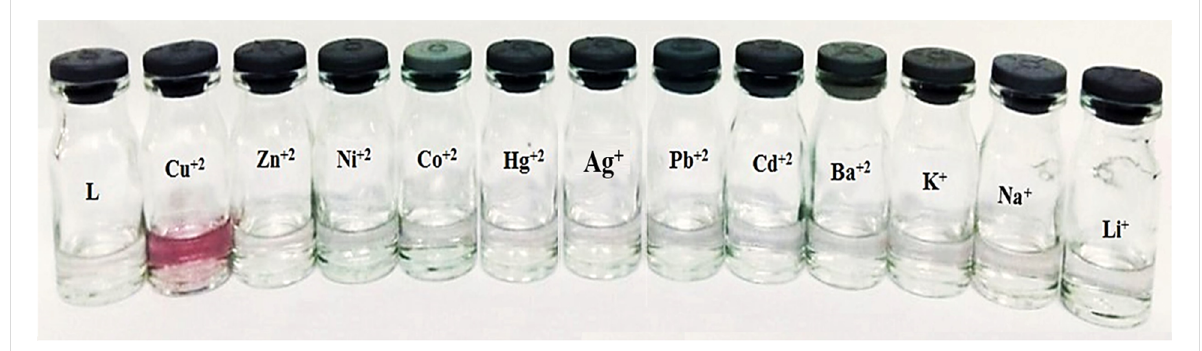
Figure 2: Color changes of receptor L upon addition of 10 equiv of various metal ions as their perchlorate salts.